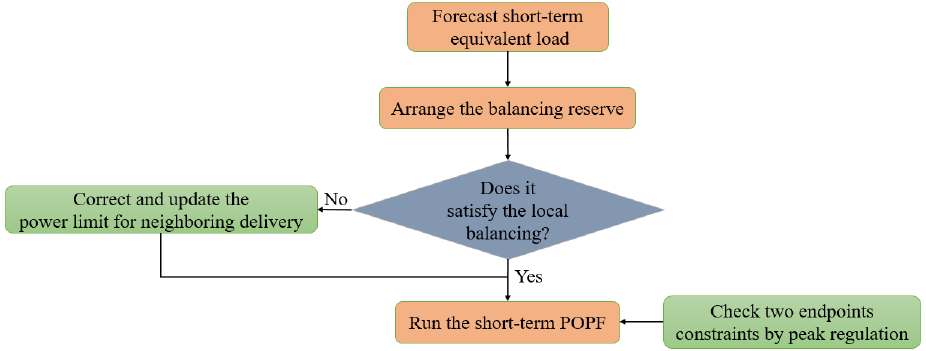
Figure 6. Day-ahead period optimal power flow